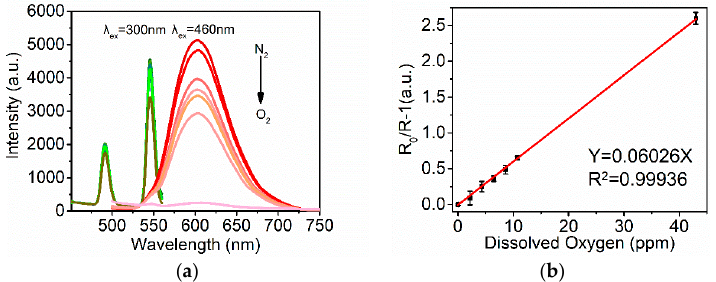
Figure 5. Oxygen sensitivity of Ru-Tb NPs in aqueous solution: ( a ) Emission spectra under 300 nm and 460 nm excitation at various oxygen concentrations (from top to bottom is 0 (nitrogen saturated), 2.15, 4.3, 8.6, 10.75, and 43 ppm (oxygen saturated) in sequence). ( b ) Ratio of red and green luminescent intensity-based Stern − Volmer plot. The experimental data (scatter) were calculated from the ratio luminescence intensities at 610 and 545 nm and linearly fitted (solid line).